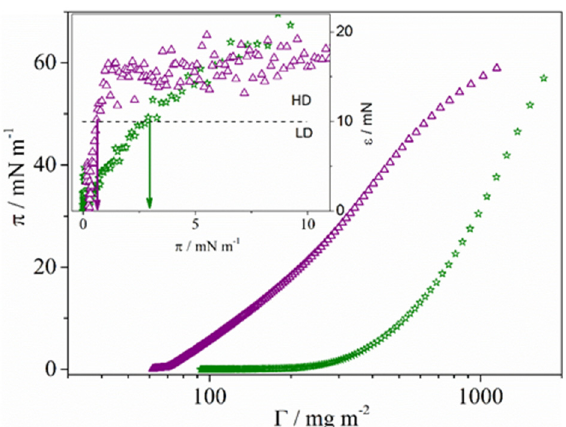
Figure 3. Surface pressure isotherms as a function of the nanowire mass for C8-AgNWs (stars) and C18-AgNWs (triangles). The variation of the surface compressional modulus with the surface pressure is represented in the inset.